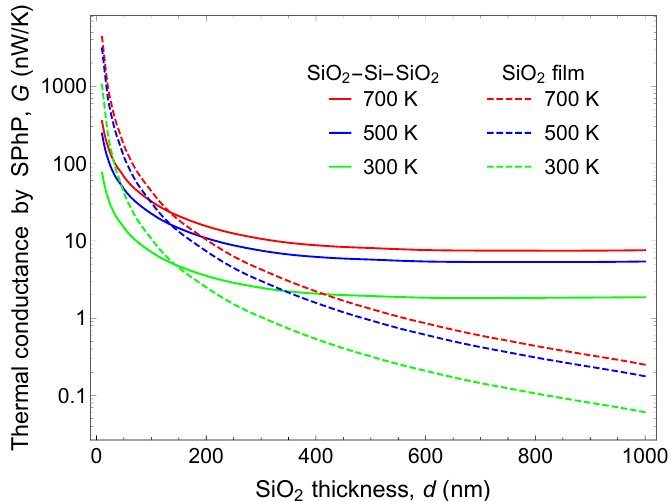
Figure 5. A comparison of the SPhPs thermal conductances of the SiO 2 /Si (10 µ m)/SiO 2 three-layer structure and of a single SiO 2 film at 300, 500 and 700 K, for different SiO 2